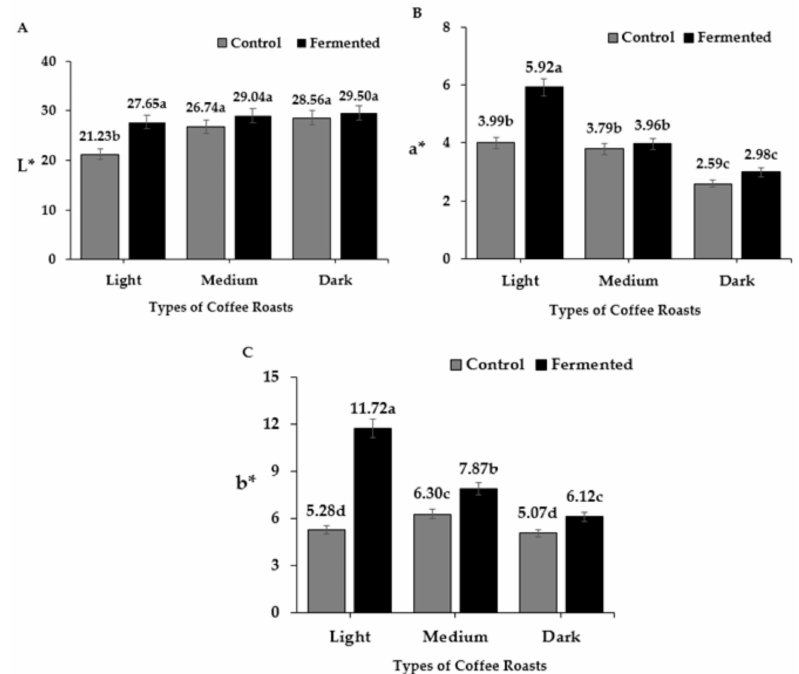
Figure 3. Colorimeter (L*, a* and b*) values of fermented roasted and ground co ff ee ( A – C ). Bars with di ff erent letters indicate a significant di ff erence ( p < 0.5) among